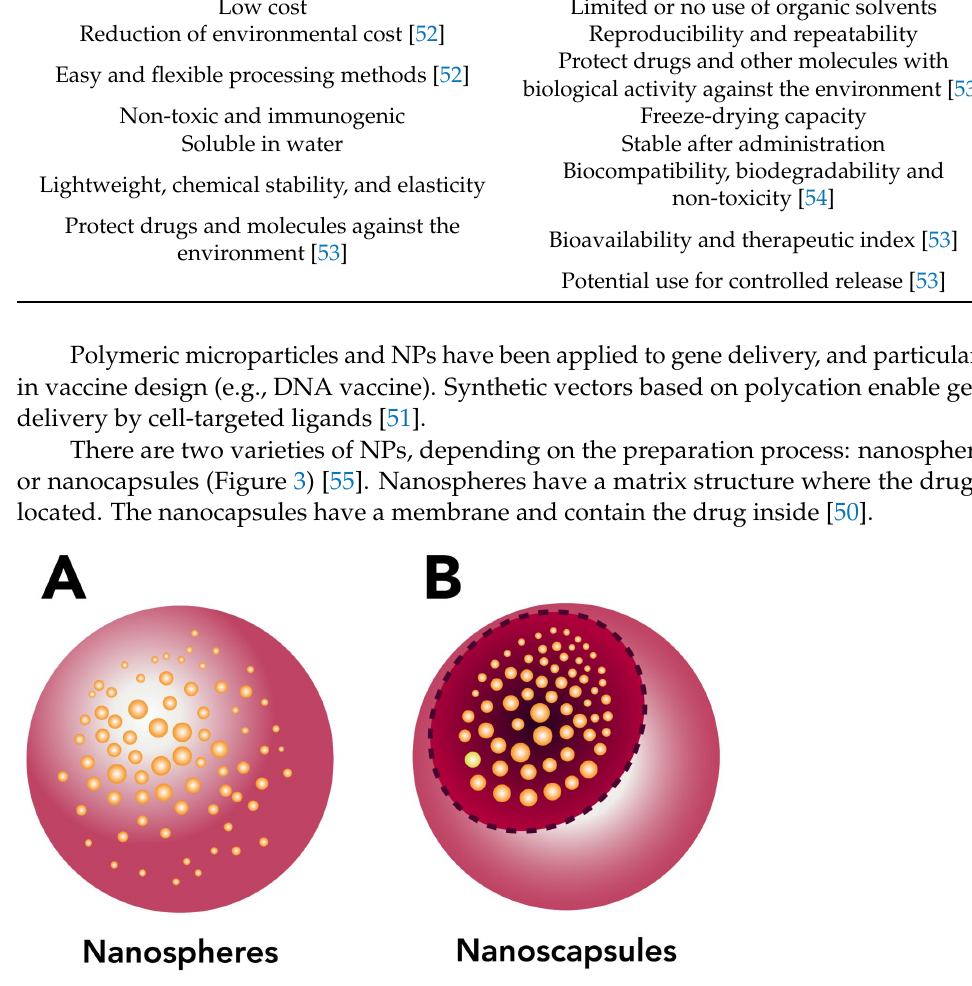
Figure 3. ( A ) Scheme of nanospheres where the active is dispersed throughout the particle. ( B ) Scheme of nanocapsules where the active is in the